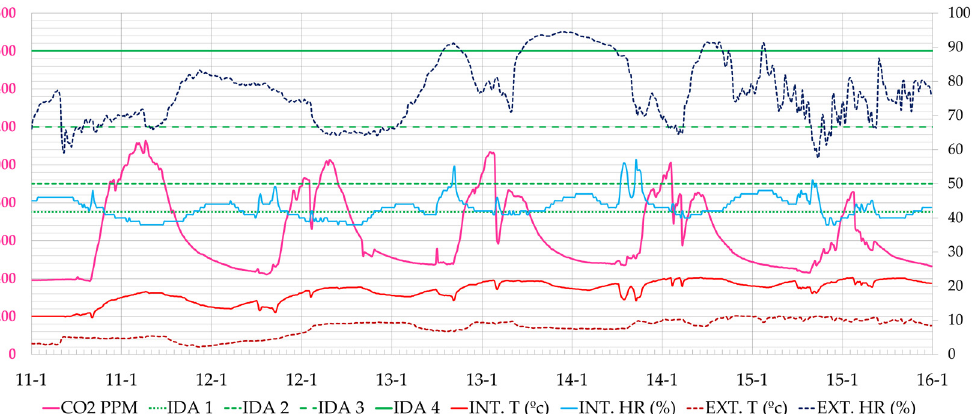
it maintained at all times reduced values of CO 2 concentration, reaching the maximum value on 11 January 2021 with a maximum value of 1126 ppm. The CO 2 limit values were reached in short periods during the middle of the day, as seen in Figure 13.